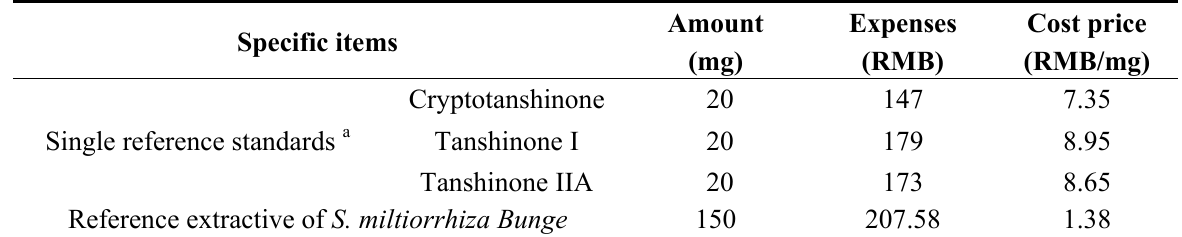
Table 9. Preparation costs for the reference extractive and single reference